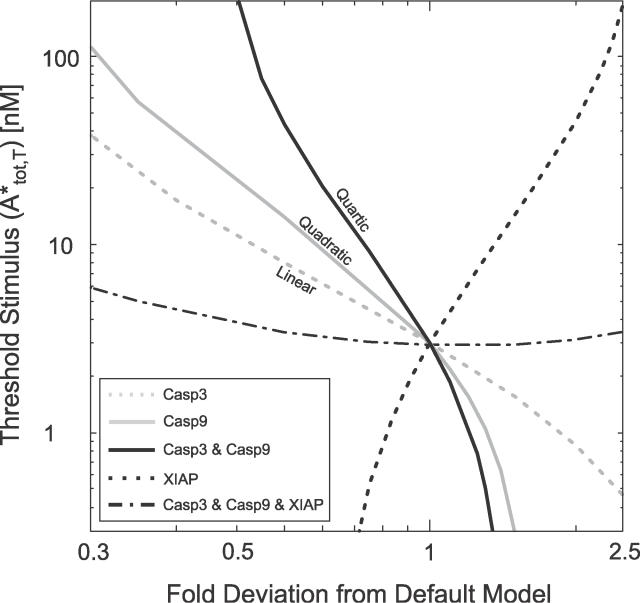
Binary Integration of Multiple InputsThe threshold stimulus, A*tot,T, where the bistable system switches from the lower to the higher steady state (point 2 in Figure 2B), is plotted as a function of Casp3 (gray dotted line), Casp9 (gray solid line), or XIAP (black dashed line) expression. In addition, the impact of simultaneous alterations of Casp3 and Casp9 (black solid line) or of Casp3, Casp9, and XIAP (black dash-dotted line) to the same relative extent is shown. The intersection of the graphs corresponds to the default protein concentrations (see Table 1). The terms “linear,” “quadratic,” and “quartic” indicate the relationship between protein expression and the apoptotic threshold, A*tot,T.